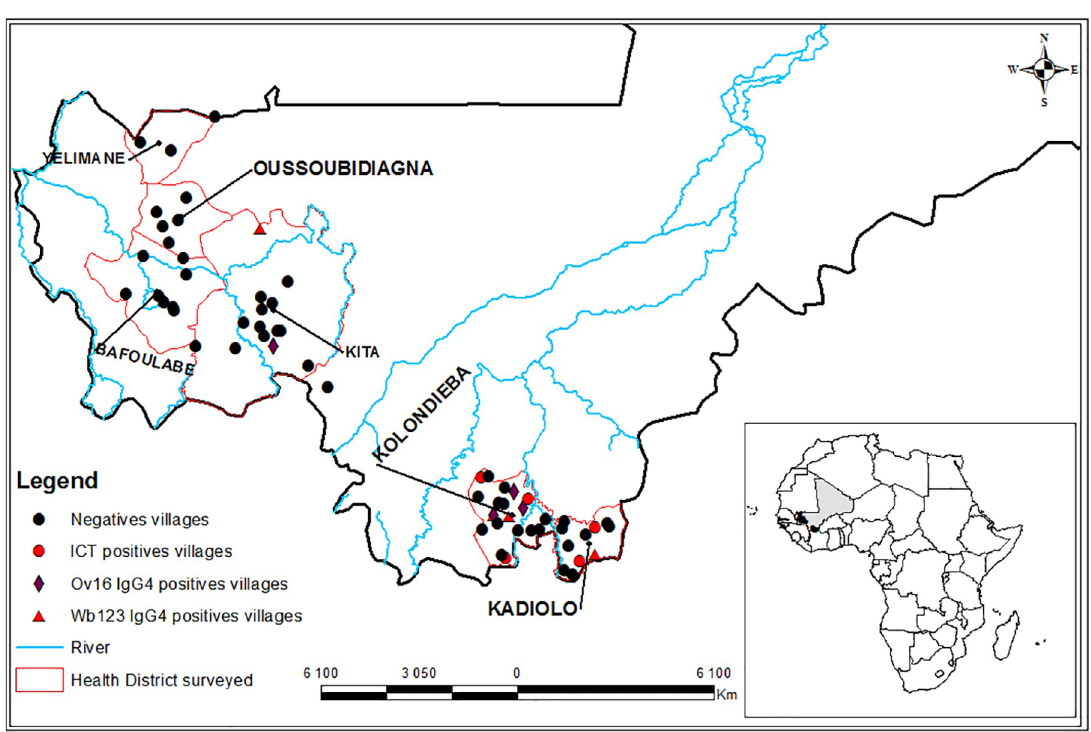
Fig 1. Distribution of circulating filarial antigen (orange dots) IgG4 antibodies to Wb123 (red dots) and to Ov16 (blue dots) in the evaluation units of Kadiolo–Kolondieba and Bafoulabe -Kita-Oussoubidiagna-Yelimane. Source: figure created by Dansine Diarra (geographer) specifically for this article. The authors retain copyright and authorize its distribution open